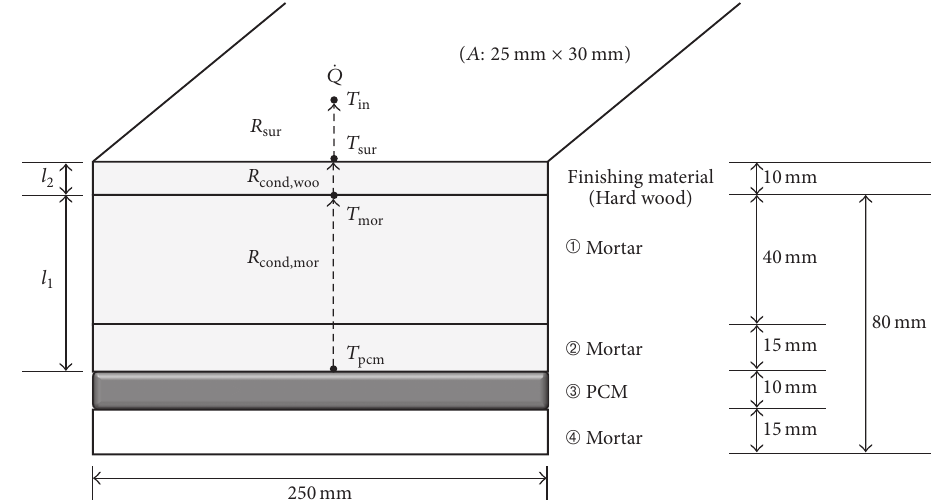
Figure 3: Mathematical model for producing optimal PCM for PCM underfloor heating